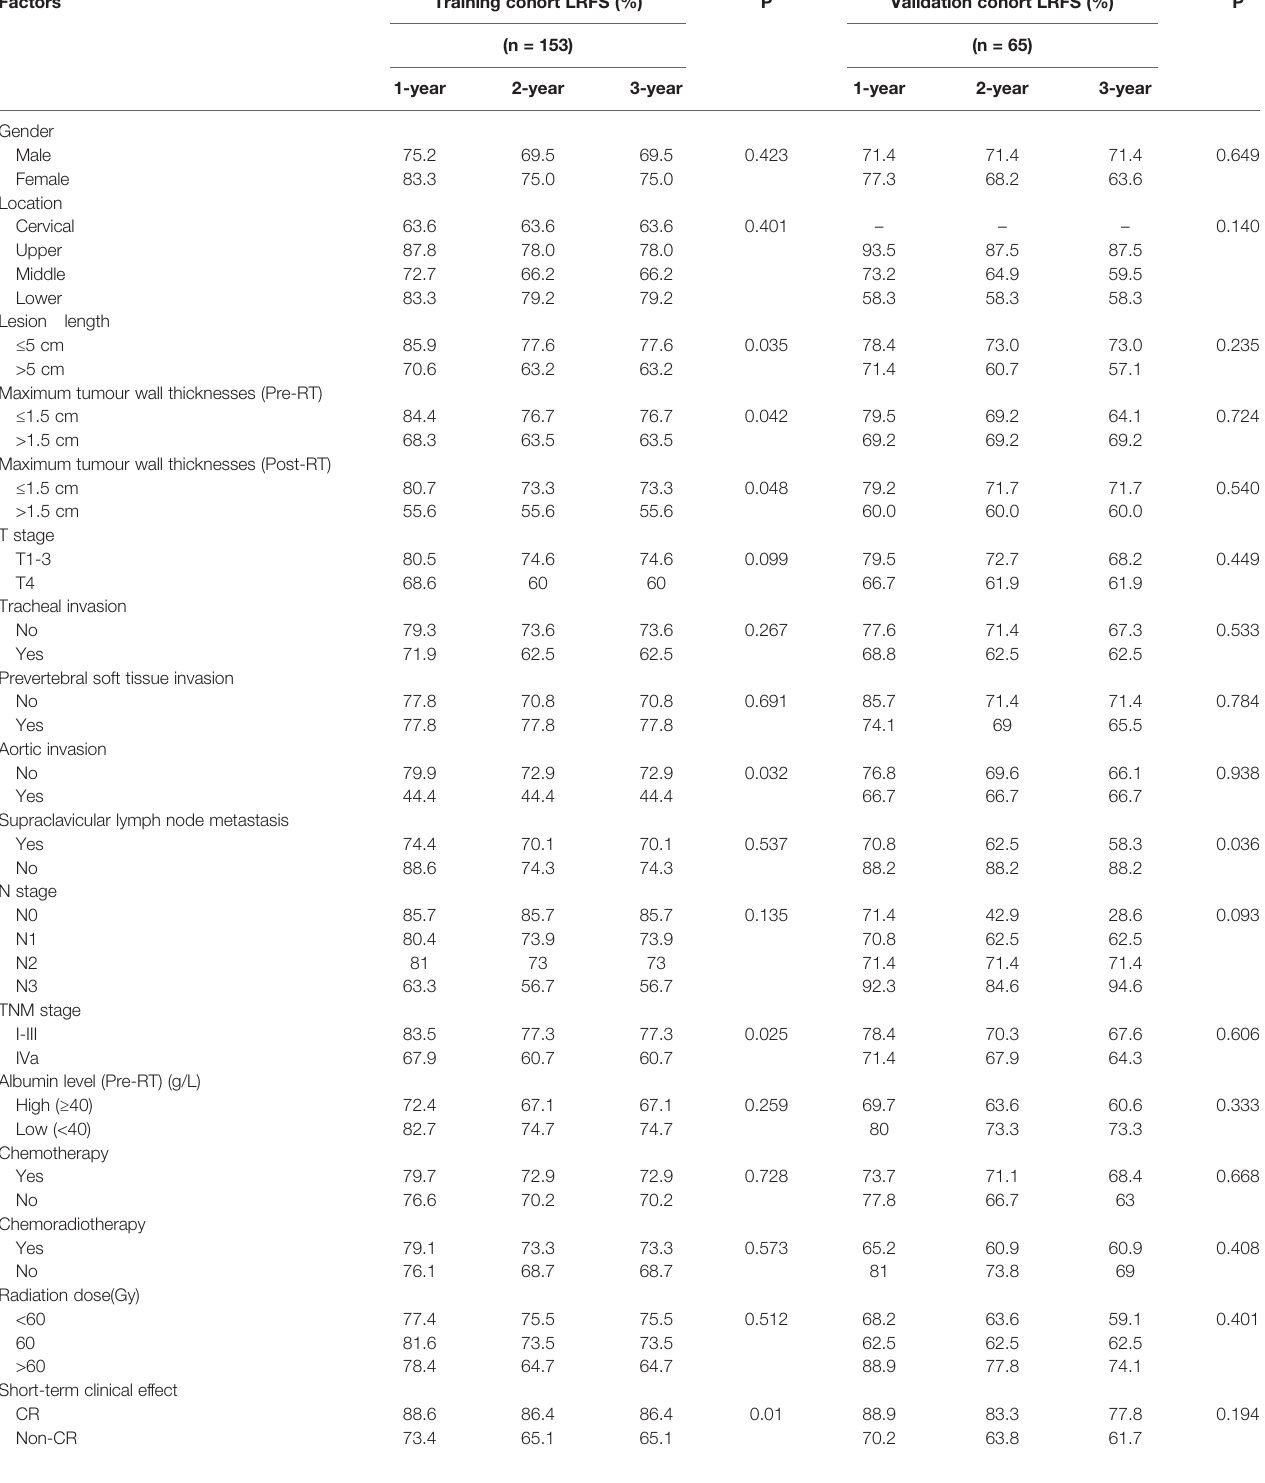
TABLE 2 | Relationship between general clinical characteristics and LRFS in patients with oesophageal cancer. Factors